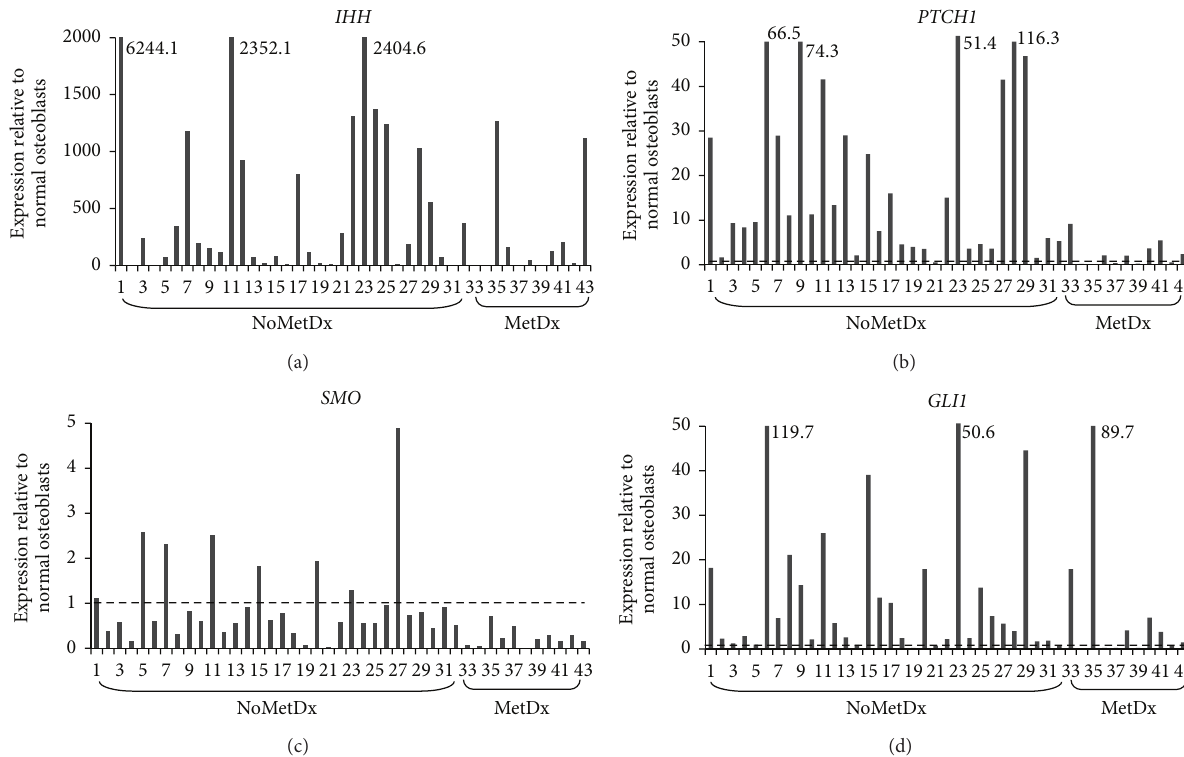
Figure 1: Expression levels of IHH , PTCH1 , SMO, and GLI1 in 43 osteosarcoma tumors relative to normal osteoblasts. Expression levels in tumors were normalized to the average level of 2 normal osteoblast samples and presented as fold change. Fold changes greater than the 𝑦 -axis are labelled next to the representing bars (NoMetDx = no metastasis at diagnosis; MetDx = metastasis at